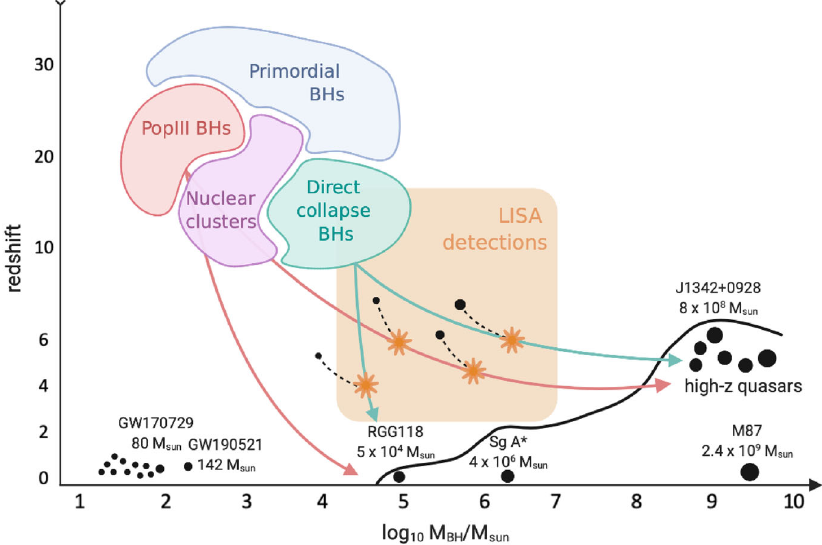
Fig. 22 Pathways towards the formation of MBHs are numerous, and include the collapse of fi rst- generation stars ( Pop III BHs , MBH . 10 3 M (cid:3) ), the collapse and/or coalescence of massive stars formed in compact stellar clusters ( nuclear clusters , 10 2 M (cid:3) . M BH . 10 4 M (cid:3) ), the collapse of SMS formed in primordial environment ( direct collapse , M BH J 10 3 M (cid:3) ), and the collapse of cosmological density perturbations ( primordial BHs , 1 M (cid:3) . M BH . 10 10 M (cid:3) ). The shaded orange region shows the redshift and MBH mass ranges of LISA, and the orange starburst symbols the LISA detections. LISAwill signi fi cantly extend the current MBH EM detections, shown below the curved solid black line (from the local Universe at z (cid:1) 0 to the high-redshift quasars at z > 6). Image credit: Melanie